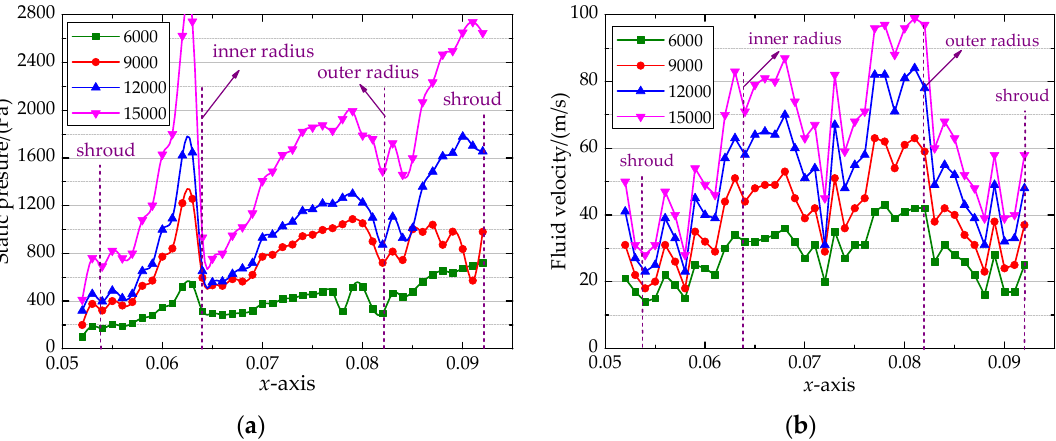
Figure 10. The distribution with shroud at different rotational speeds of: ( a ) static pressure; ( b ) fluid velocity.